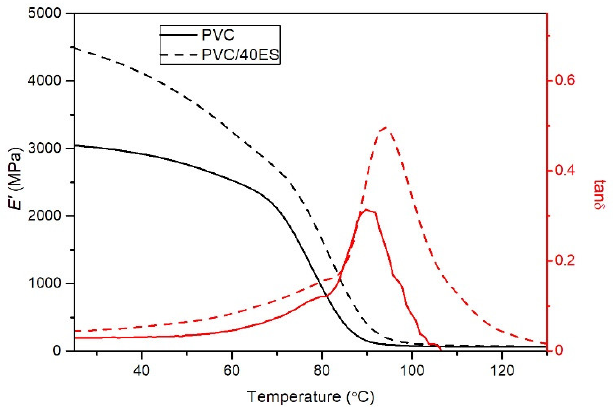
Figure 7. Vicat softening temperature (VST) vs. ES content.